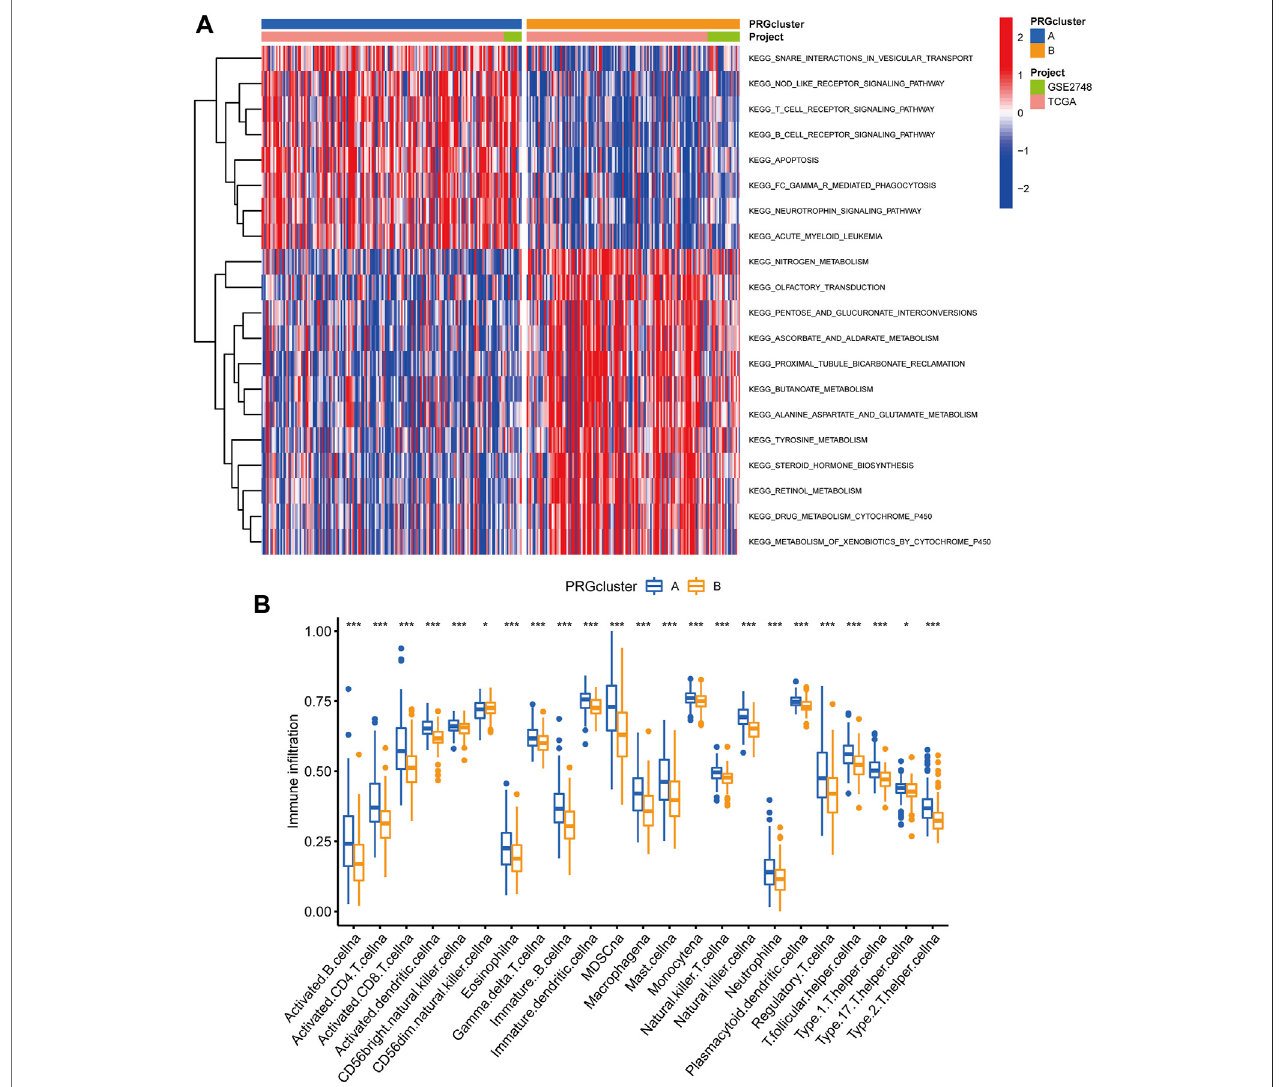
FIGURE 3 | Analysis of GSVA enrichment and TME immune cell in fi ltration. (A) The functional pathways of two PRG subgroups were identi fi ed using GSVA enrichment. (B) Immune cell in fi ltration levels differ between PRG subgroups.